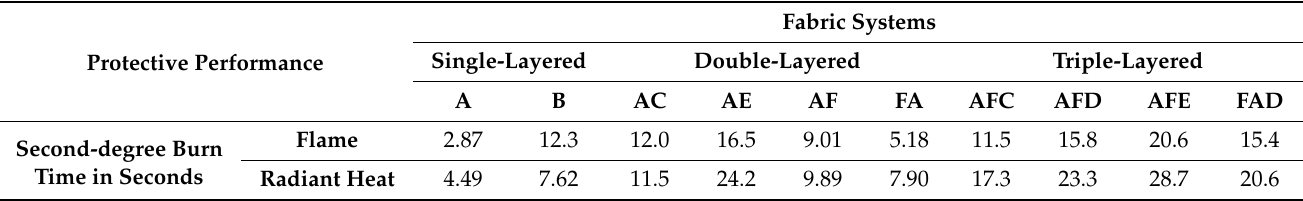
Table 4. Flame and radiant heat protective performance of selected fabric systems [adapted from Mandal, et al. (2013)] [7].